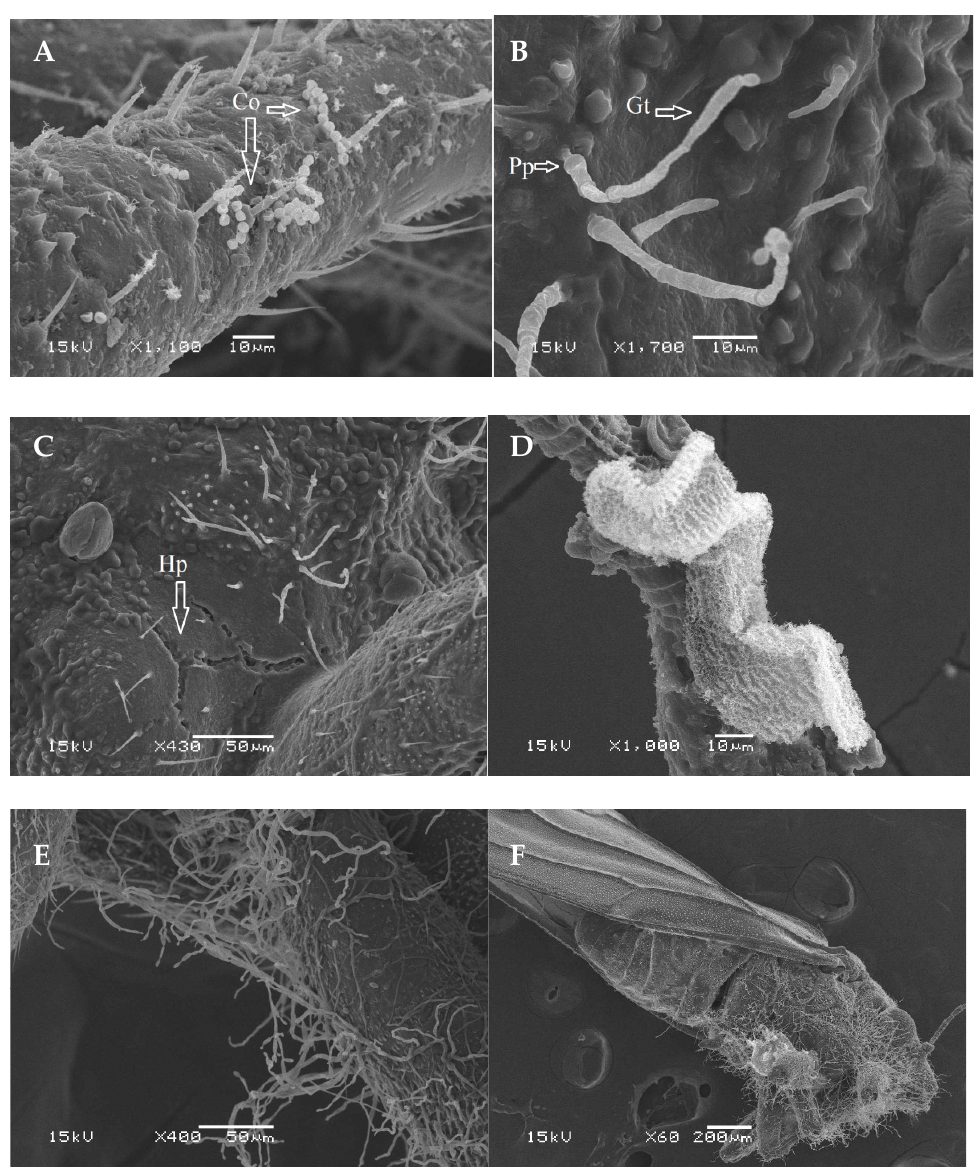
Figure 4. Ultrastructural observations of Diaphorina citri infected with Cja Apopka 97; ( A ) conidia (Co) adhering to the legs after 24 h post-inoculation; ( B ) germ tube formation (Gt) after 24 h post-inoculation formation of penetration pegs (Pp), and mycelia growth after 72 h post-inoculation; ( C ) rupturing of cuticle due to hyphal penetration (Hp) after 96 h post-inoculation; ( D ) mycelial mass on antennae surrounded after 120 h post-inoculation; ( E ) hyphae growing on the wings after 72 h post-inoculation; ( F ) mycelia colonizing D. citri body after 144 h post-inoculation.